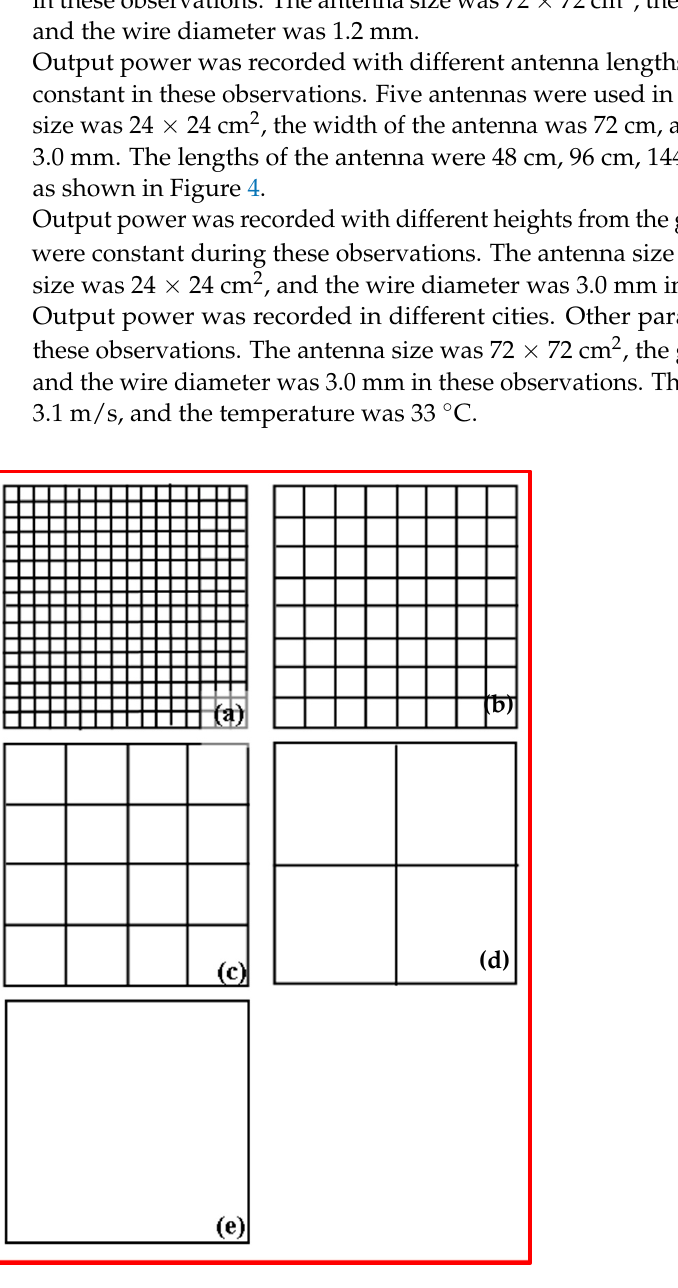
Figure 2. A set of antennas with different antenna gaps in which the wire diameter was 1.6 mm and the gross area was 72 × 72 cm 2 . The areas of the gaps were ( a ) 6 × 6 cm 2 , ( b ) 12 × 12 cm 2 , ( c ) 24 × 24 cm 2 , ( d ) 36 × 36 cm 2 , and ( e ) 72 × 72 cm 2 .